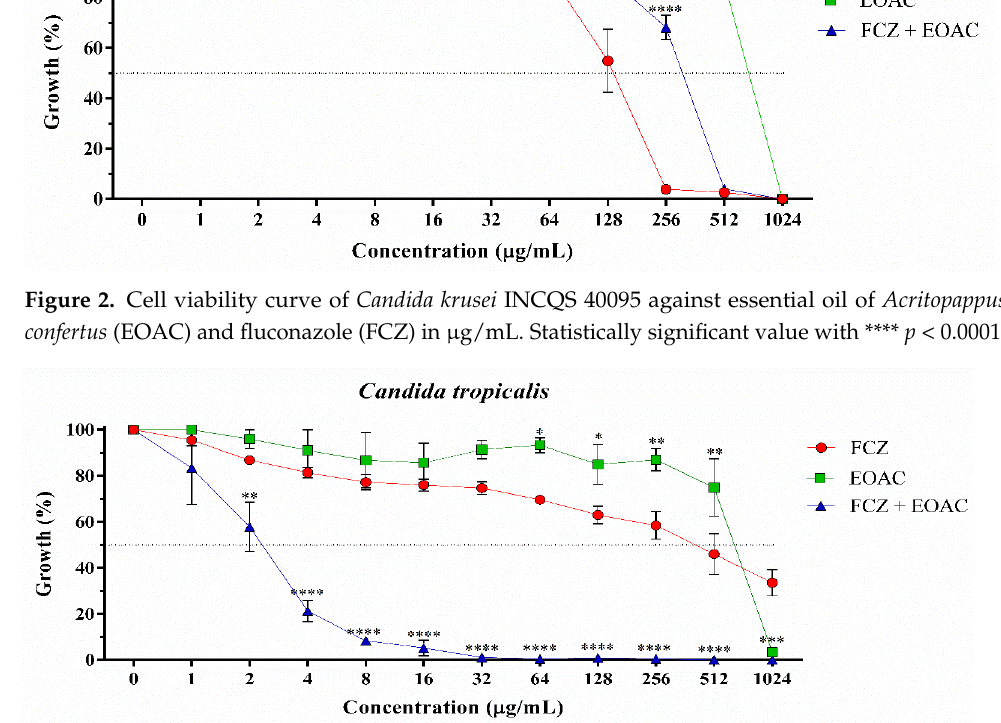
Figure 3. Cell viability curve of Candida tropicalis INCQS 40042 against essential oil of Acritopappus confertus (EOAC) and f luconazole (FCZ) in μg/mL. Anti - Candida potential of essential oil of Acritopappus confertus against strains of Candida tropicalis . Statistically significant value with * p < 0.05, ** p < 0.01, *** p < 0.001 and **** p < 0.0001.